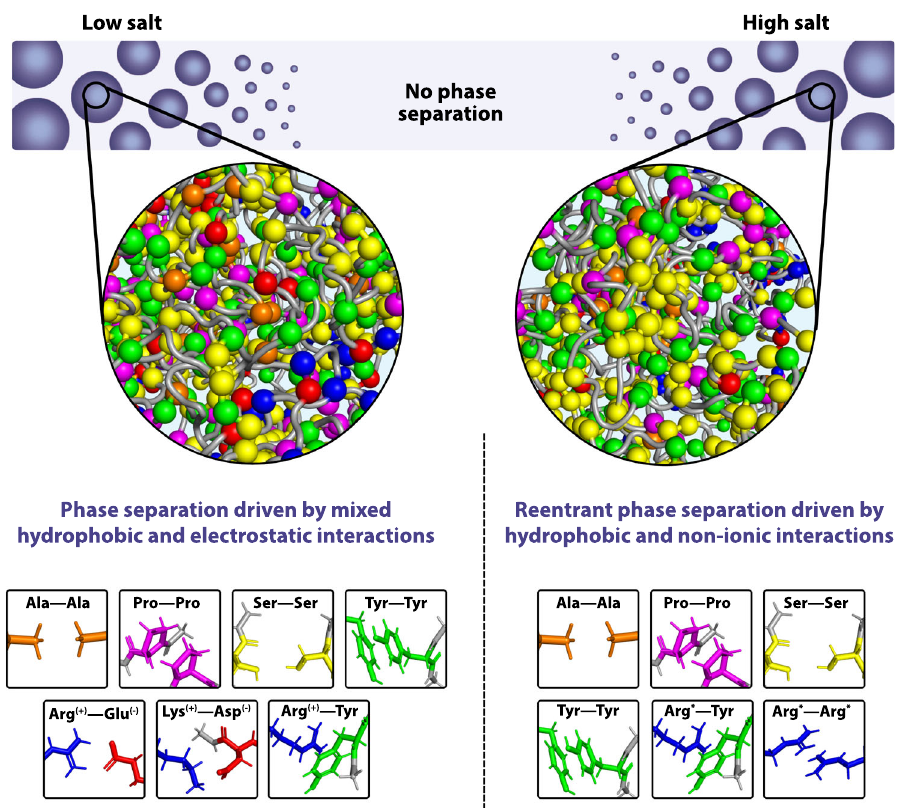
Fig. 8 Schematic illustration of the different molecular forces that stabilize condensates in the low-salt versus the high-salt reentrant regime. While phase separation in the low-salt regime is driven by both electrostatic and hydrophobic interactions, the condensation process in the reentrant high-salt regime is governed by hydrophobic and nonionic interactions. Note: The asterisks (*) for Arg* – Try and Arg* – Arg* indicate that at high salt, charges are screened, and interactions become predominantly hydrophobic (i.e., π – π